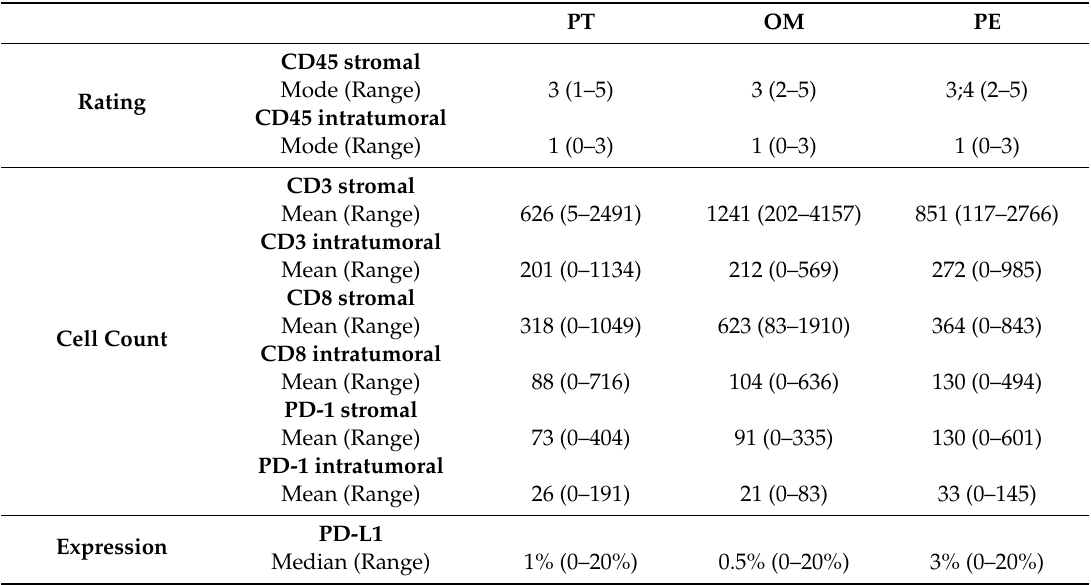
Table2. Densityandspatialdistributionofimmunecellphenotypesindi ff